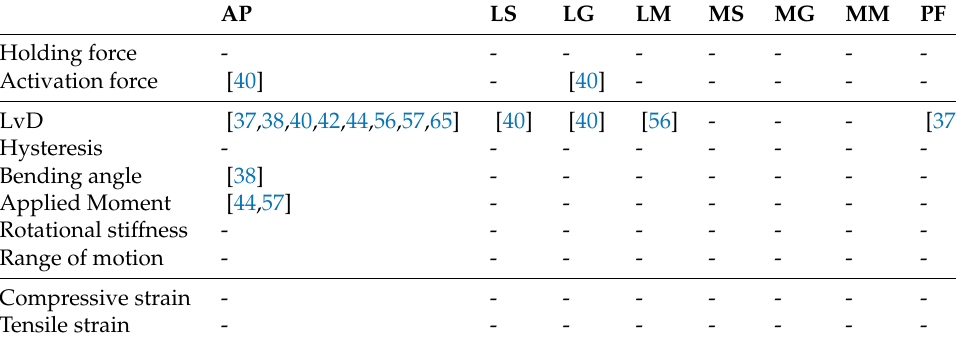
Table 11. Frequency of varying layer jamming parameters per metric.